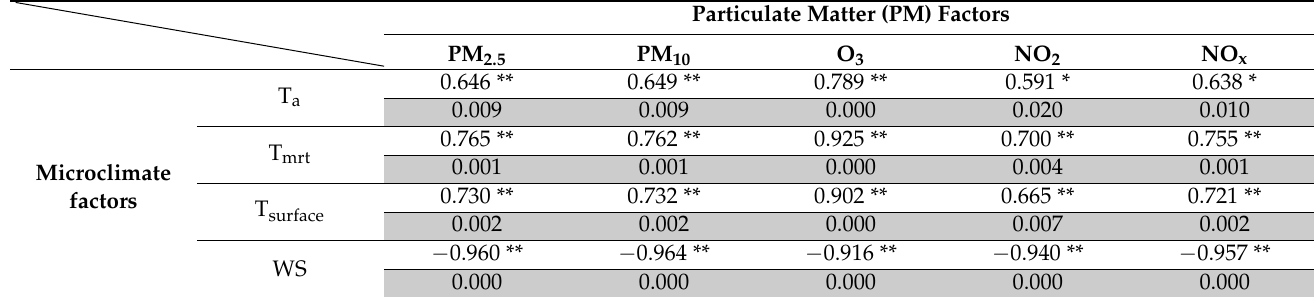
Table 3. Effects of floor area ratio on microclimate and air quality. Table 4. Correlation between microclimate and PM elements.